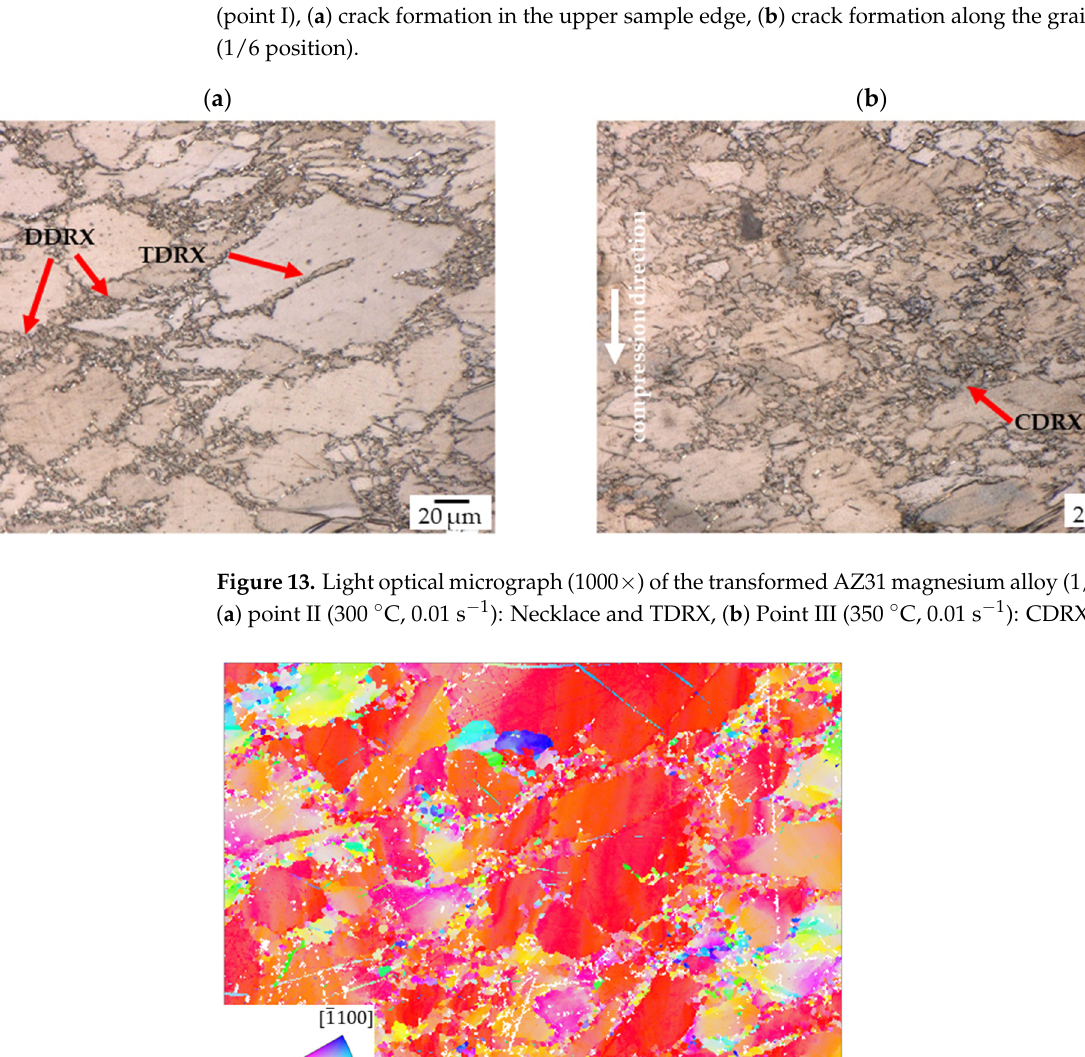
Figure 14. EBSD measurement of the transformed AZ31 magnesium alloy point II (300 °C, 0.01 s − 1 ): necklace along the grain boundaries, typical DDRX.